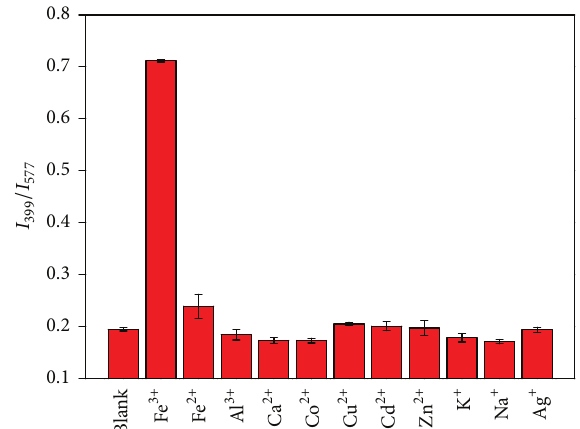
Figure 5: Selectivity of the CD-RhB probe toward Fe 3+ over other ions. The concentration of metal ions is 1.0 𝜇 M. The error bars represent standard deviations based on three independent